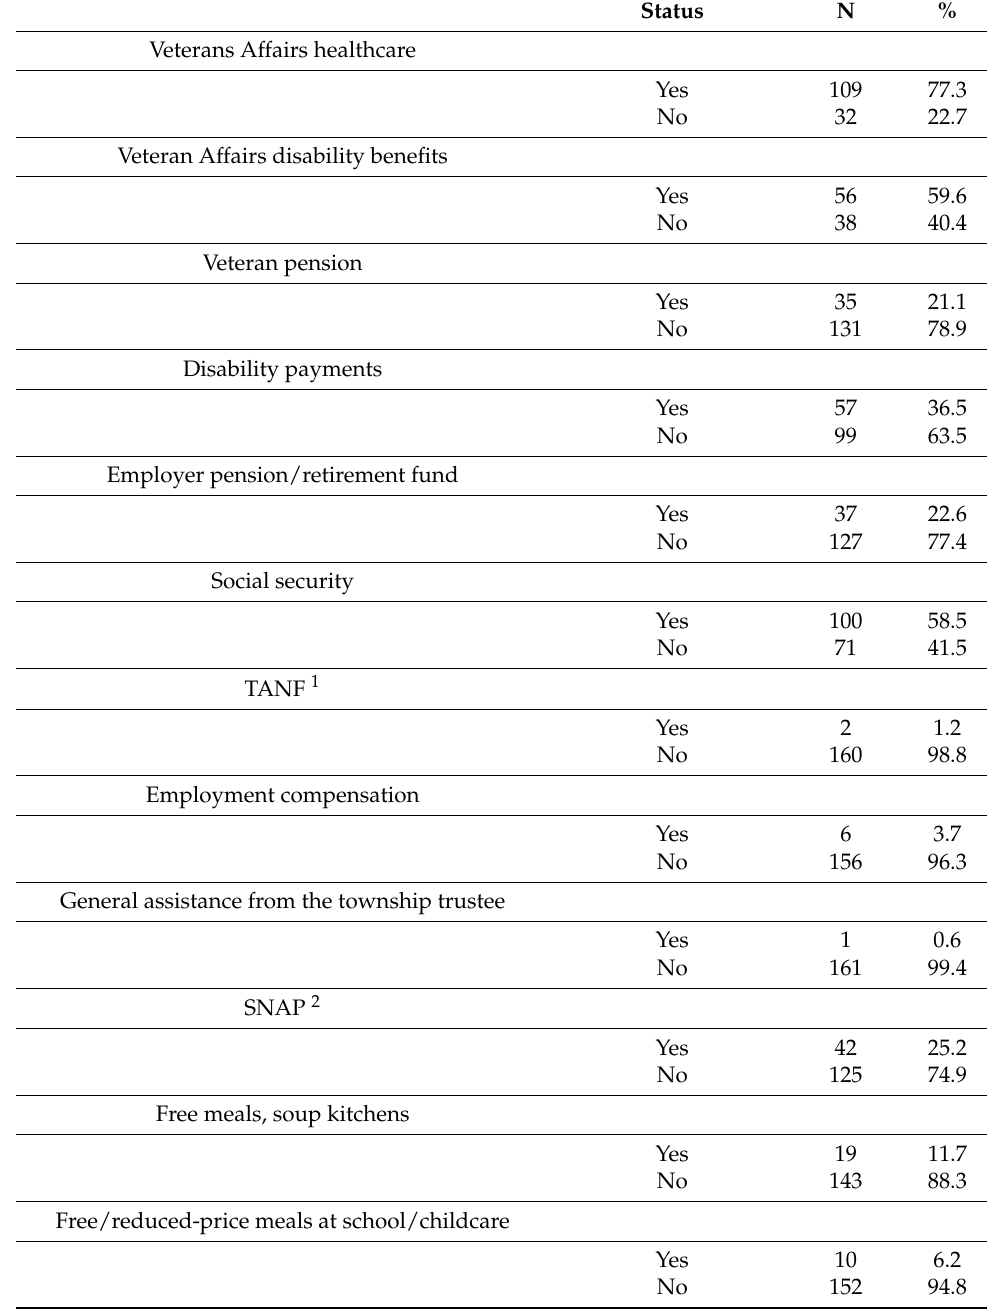
Table 2. Resource use and food security status among rural Illinois veterans ≥ 18 years recruited from five food pantries from March 2021 to November